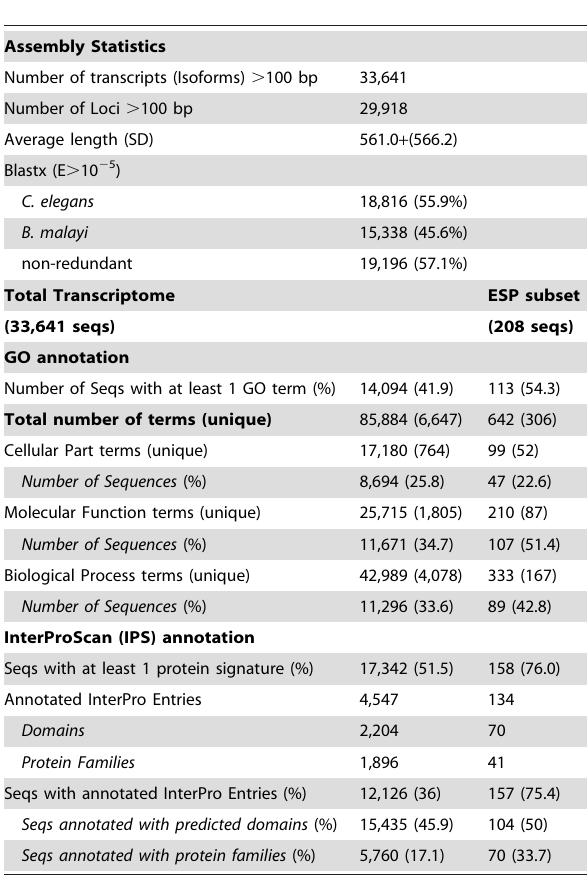
Table 1. Summary of the transcriptomic assembly and ESP subset